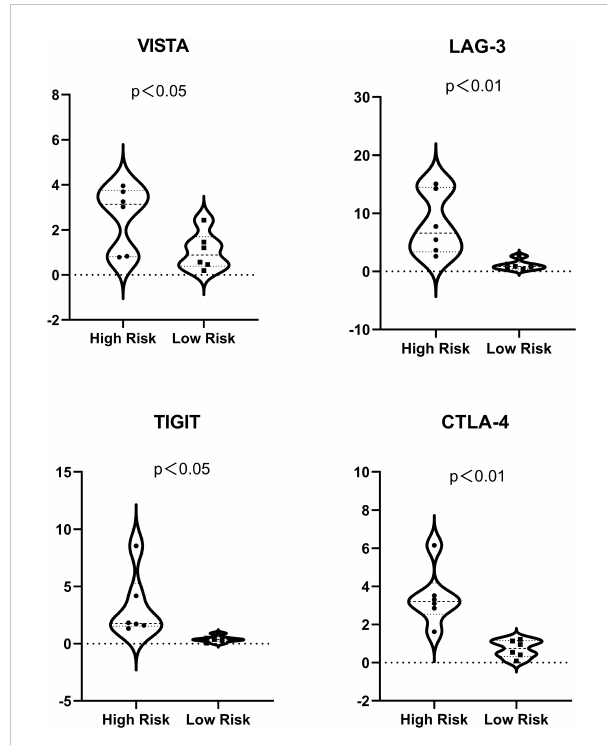
FIGURE 6 Expression of immune checkpoints (VISTA, LAG-3, TIGIT, and CTLA- 4) in the high- and low-risk samples. For ease of reading, the unit of the vertical axis is